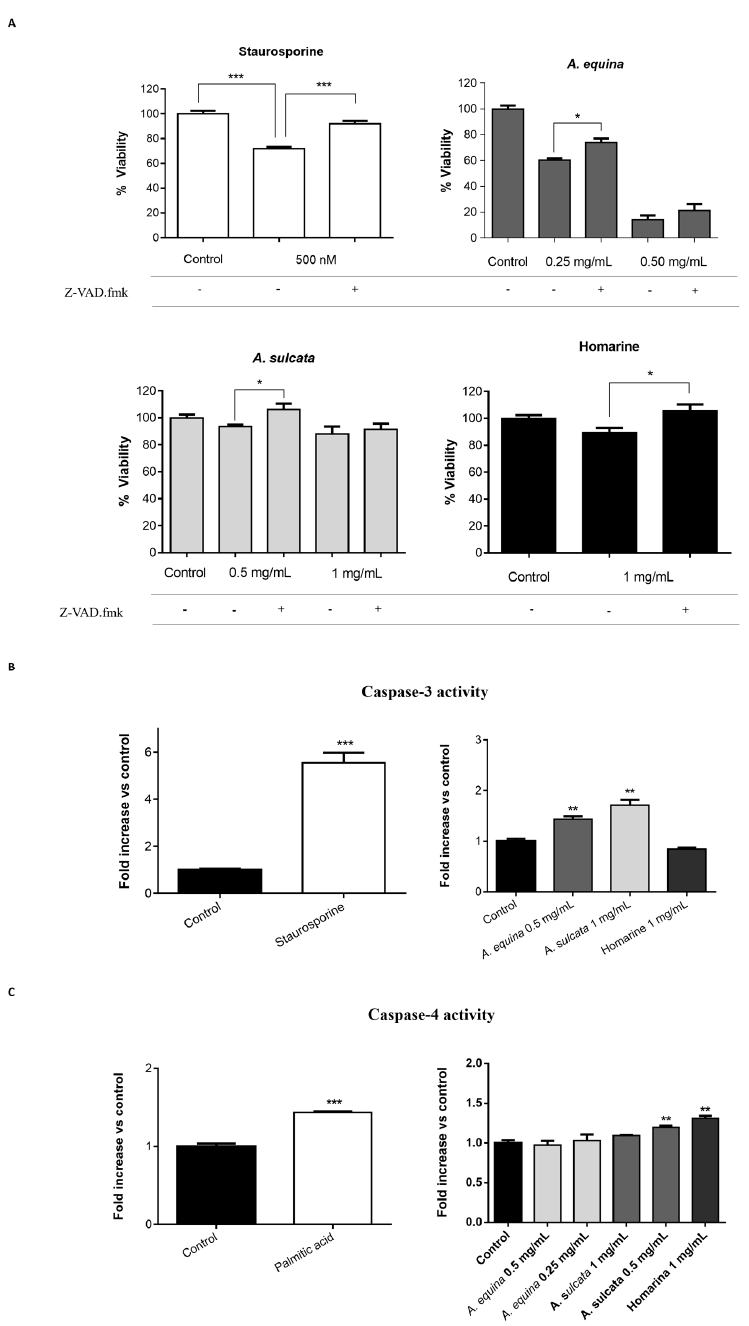
Figure 8. ( A ) Effect of Z-VAD.fmk in AGS cell death caused by extracts and homarine, evidencing that incubation with the pan-caspase inhibitor rescues cell from toxicity; ( B ) Caspase-3 activity in AGS cells treated with aqueous extracts and homarine. At the concentrations indicated, the extracts caused an increase in caspase-3 activity. Staurosporine (500 nM) was used as a positive control for caspase activity; ( C ) Caspase-4 activity in AGS cells treated with the aqueous extracts and homarine. At the concentrations indicated, the extracts of A. sulcata and homarine caused an increase in caspase-4 activity. Palmitic acid (1 mM) was used as a positive control. Results are presented as mean ± standard error of the mean of four independent experiments performed in triplicates. Statistical significance: * p < 0.05, ** p < 0.01, *** p < 0.001.